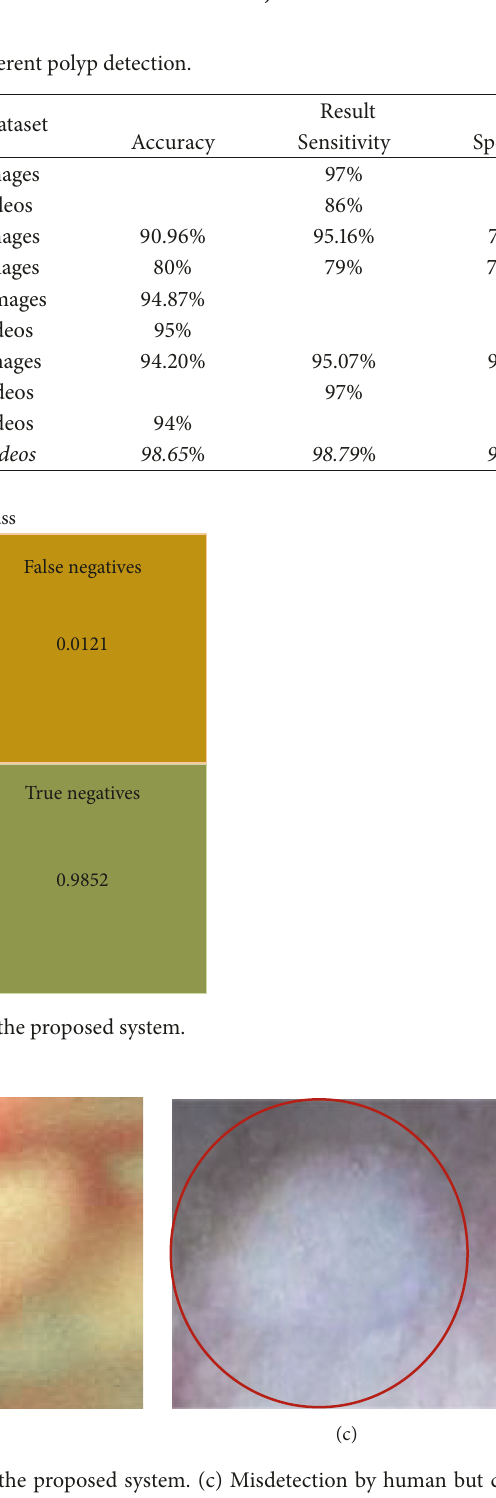
Figure 11: (a) Misdetection by the proposed system. (b) Misdetection by the proposed system. (c) Misdetection by human but correctly detected by the proposed